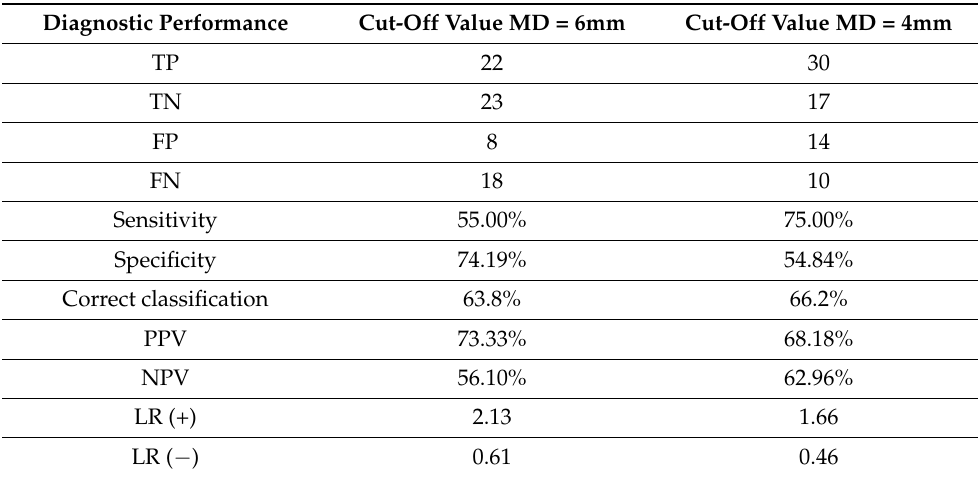
Table 5. Diagnostic performance for two criteria (cut-off values: MD = 6 mm and MD = 4) to classify UCH as active/inactive based upon MD.